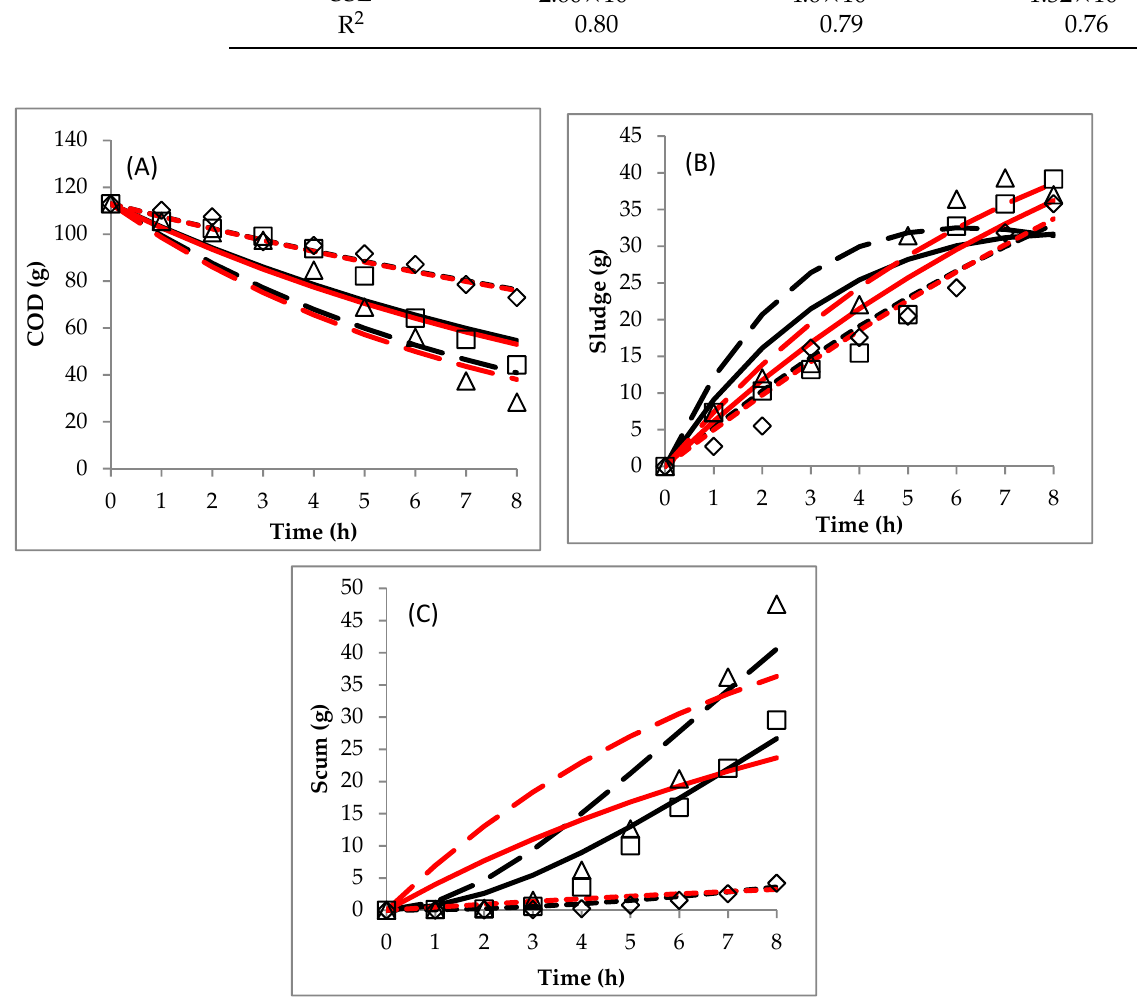
Figure 3. Comparison between experimental data and predicted data obtained by the mechanistic models: ( A ) COD, ( B ) sludge and ( C ) scum. ( ◊ , 2.5 A experimental data; □ , 3 A experimental data; ∆ , 3.5 A experimental data), (black line-square dot, 2.5 A model 1; black line-solid, 3 A model 1; black line-long dash, 3.5 A model 1) and (red line-square dot, 2.5 A model 2; red line-solid, 3 A model 2; red line-long dash, 3.5 A model 2). Table 3. Kinetic constants for the EC at various currents.